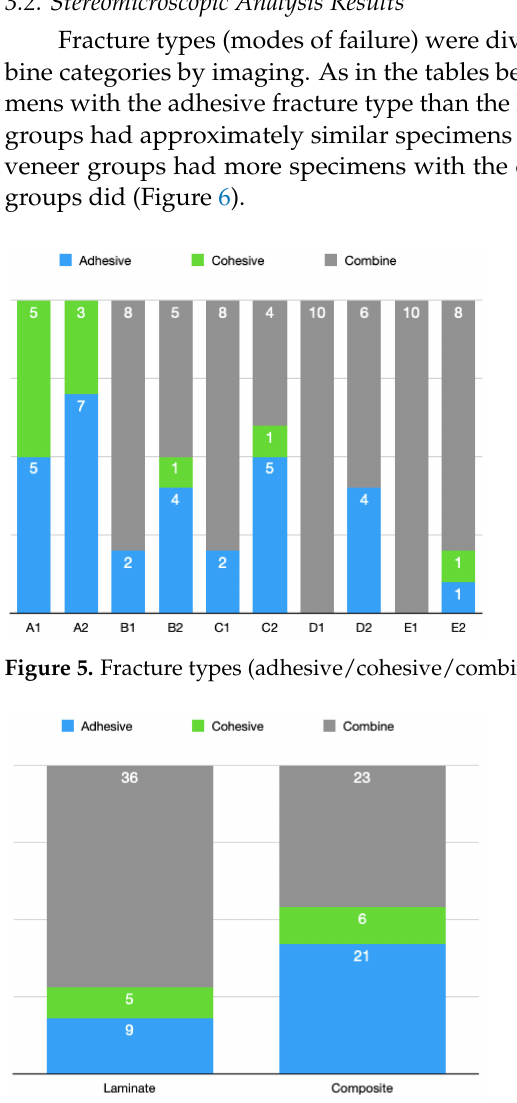
Figure 6. Fracture types (adhesive/cohesive/combine) comparisons of laminate veneer and compos- ite resin